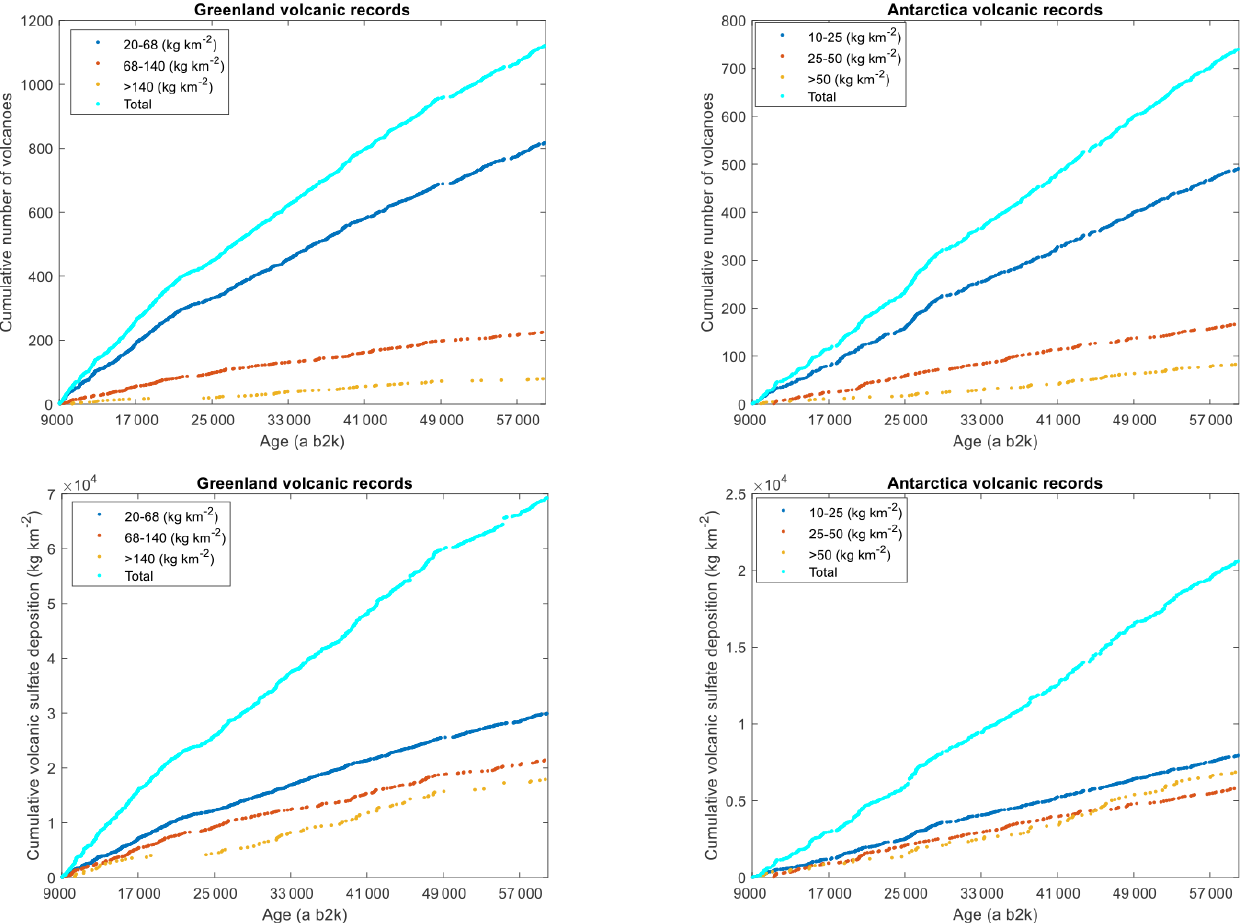
Figure 5. Cumulative number and sulfate deposition of volcanoes with time (same as in Fig. 2 and Tables S3 and S4) for three classified size fractions (same fractions as in Fig. 3) of volcanoes for Greenland and Antarctica